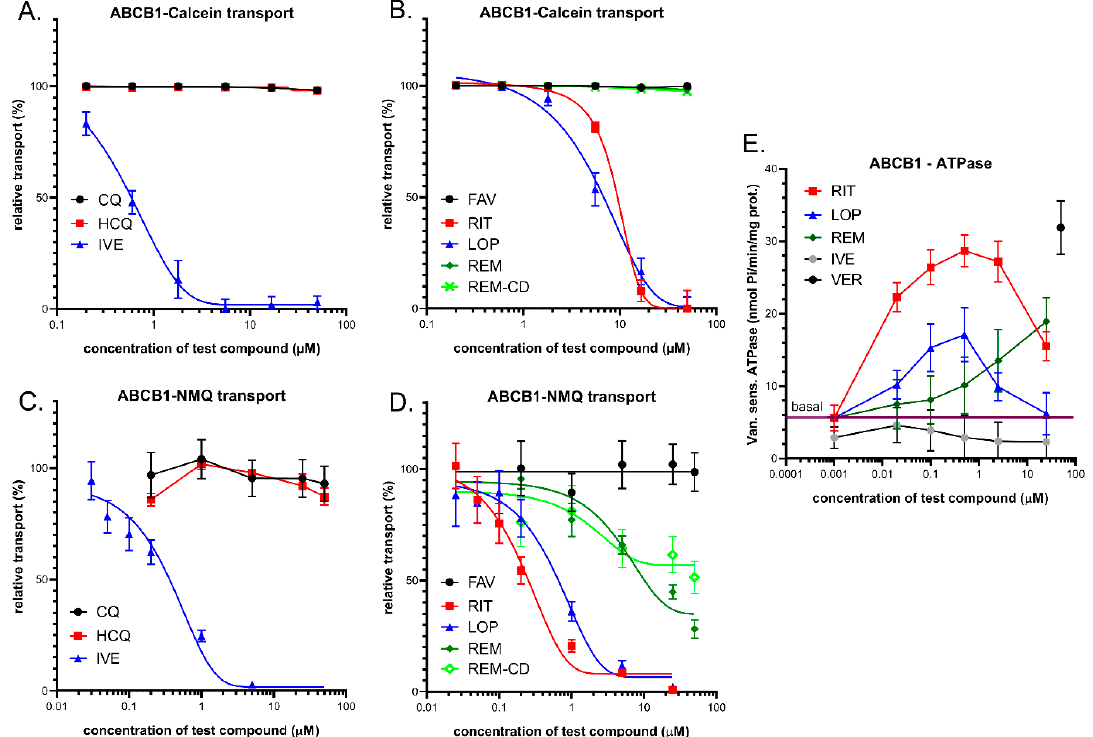
Figure 1. ( A , B ) Inhibition of ABCB1-mediated Calcein-AM (CaAM) extrusion in intact ABCB1 expressing PLB-985 cells. ( A ) Effects of ivermectin (IVE), chloroquine (CQ), and hydroxychloroquine (HCQ). ( B ) Effects of lopinavir (LOP), ritonavir (RIT), favipiravir (FAV), remdesivir (REM), and cyclodextrin formulated remdesivir (REM-CD). ( C , D ) Inhibition of ABCB1-mediated N-methyl quinidine (NMQ) transport in the vesicular transport assay. ( E ) ABCB1-ATPase activity in isolated Sf9 membrane vesicles. Effects of ivermectin, lopinavir, ritonavir, and remdesivir. As a reference substrate, verapamil (VER) was used. The basal line represents the ATPase activity level without the addition of any drug. Data on the graphs show the average of at least three independent experiments, +/- SD or SEM ( E ) values.